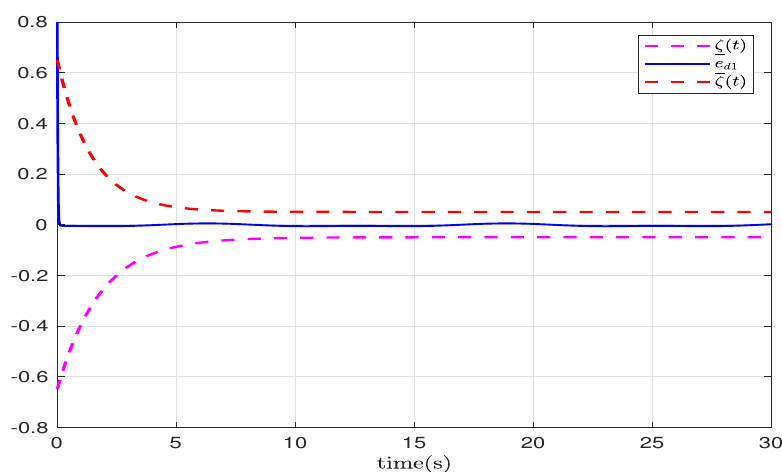
Figure 3. The trajectories of the system states x f .